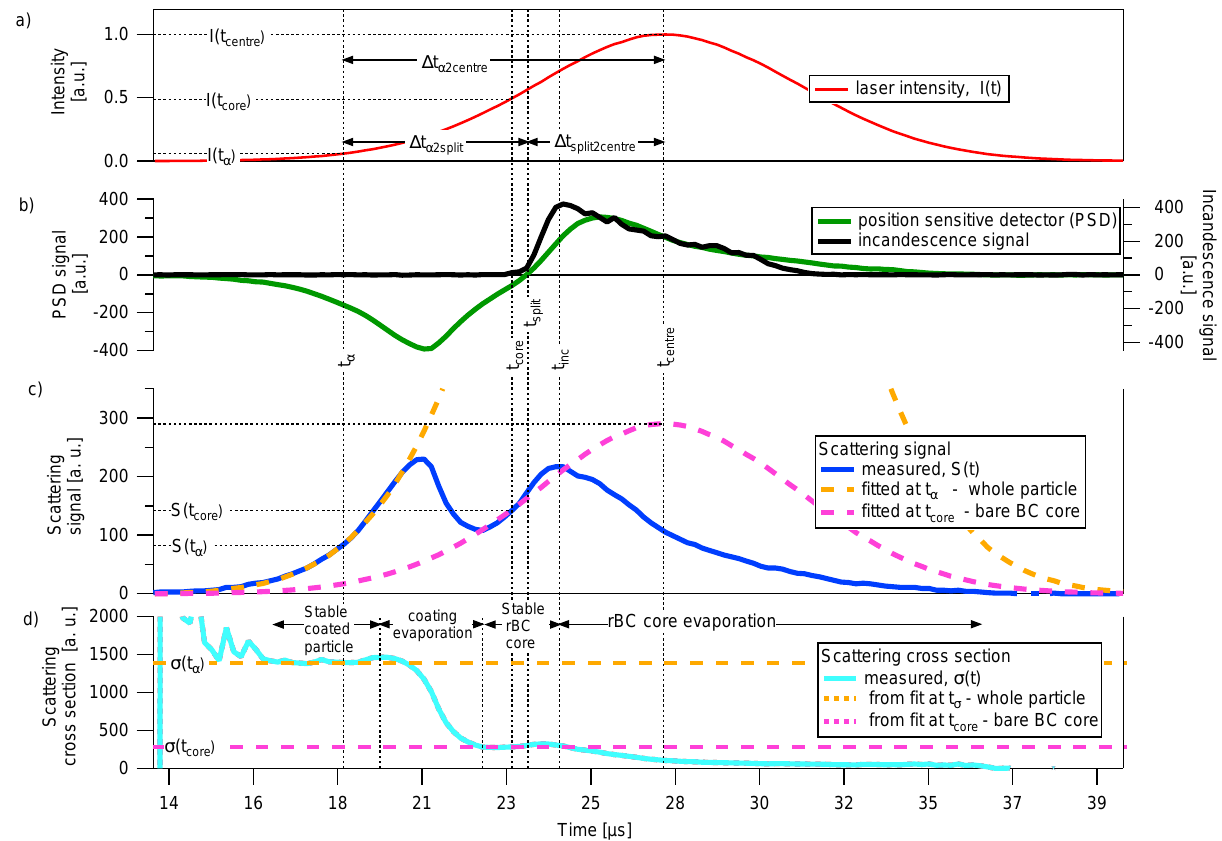
Fig. 1. Example for a rBC containing particle. (a) Laser beam intensity profile (b) incandescence and position sensitive signals (c) scattering signals (d) scattering cross section obtained by dividing scattering signal by laser intensity